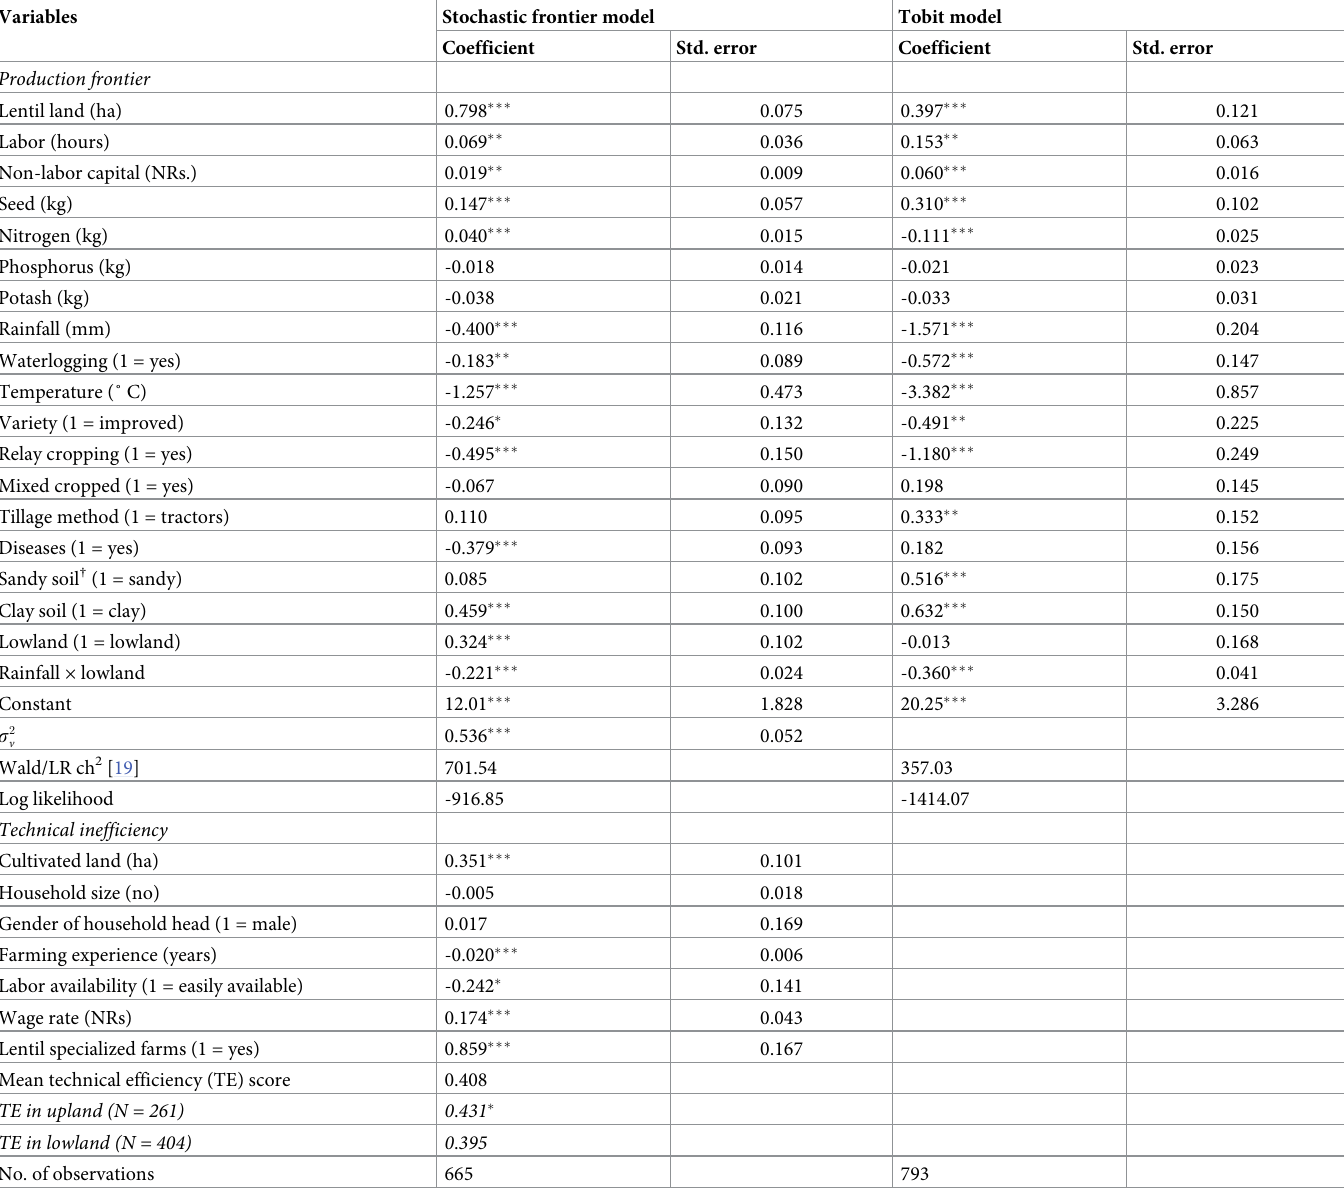
Table 3. Maximum likelihood estimates of the parameters in the stochastic production frontier for lentil production in western Nepal.